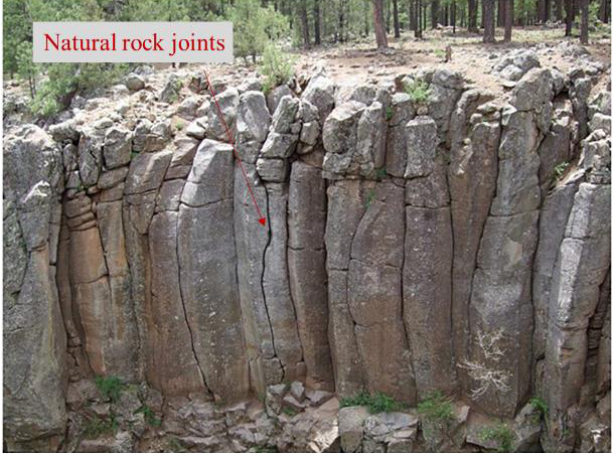
Figure 1. Example of jointed rock mass(modified after [1]).